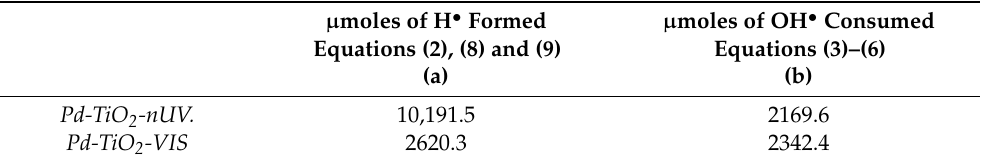
Table 1. Net µ Moles of H • formed and OH • consumed following 6 h of irradiation using the Pd-TiO 2 -nUV and Pd-TiO 2 -VIS